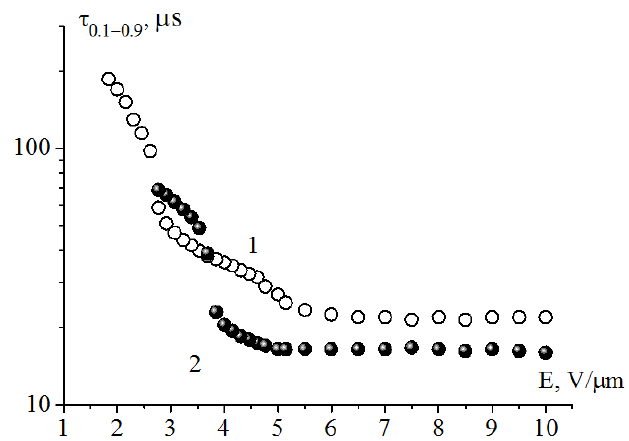
Figure 9. Field dependences of the optical response time for a cell with the HF32F composition. The thickness of the electro-optical cell is 1.7 μ m. The voltage frequencies (meander) are 200 Hz (curve 1) and 3 kHz (curve 2).